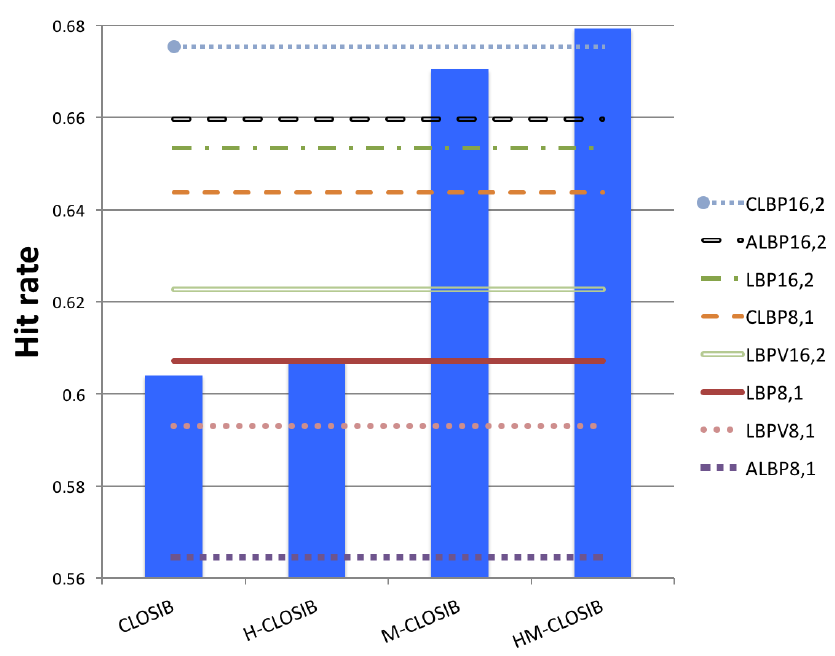
Figure 7. Hit rates when we describe KTH Tips2-a images with different CLOSIBs and LBP-based descriptors. For each CLOSIB variant –CLOSIB (standard), M-CLOSIB, H-CLOSIB and HM-CLOSIB–,